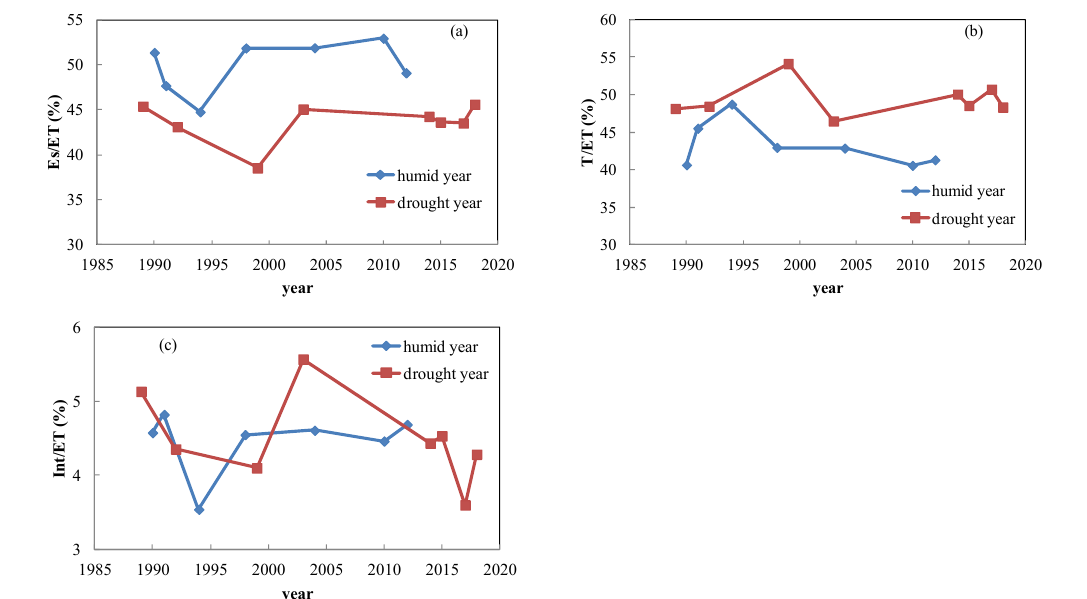
Figure 5. Fraction of AET partitioning in rainfed maize farmland during humid and drought years ( a ) Es/AET ( b ) T/AET ( c ) Int/AET. ( a ) Es/AET ( b ) T/AET ( c )